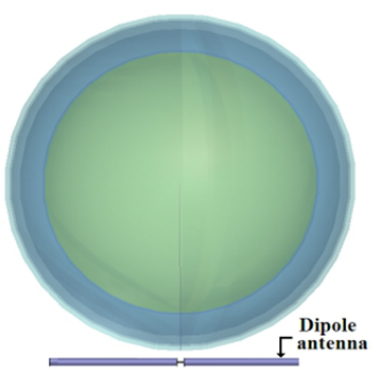
Figure 2. Model HFSS of Layered sphere irradiated by a dipole antenna.